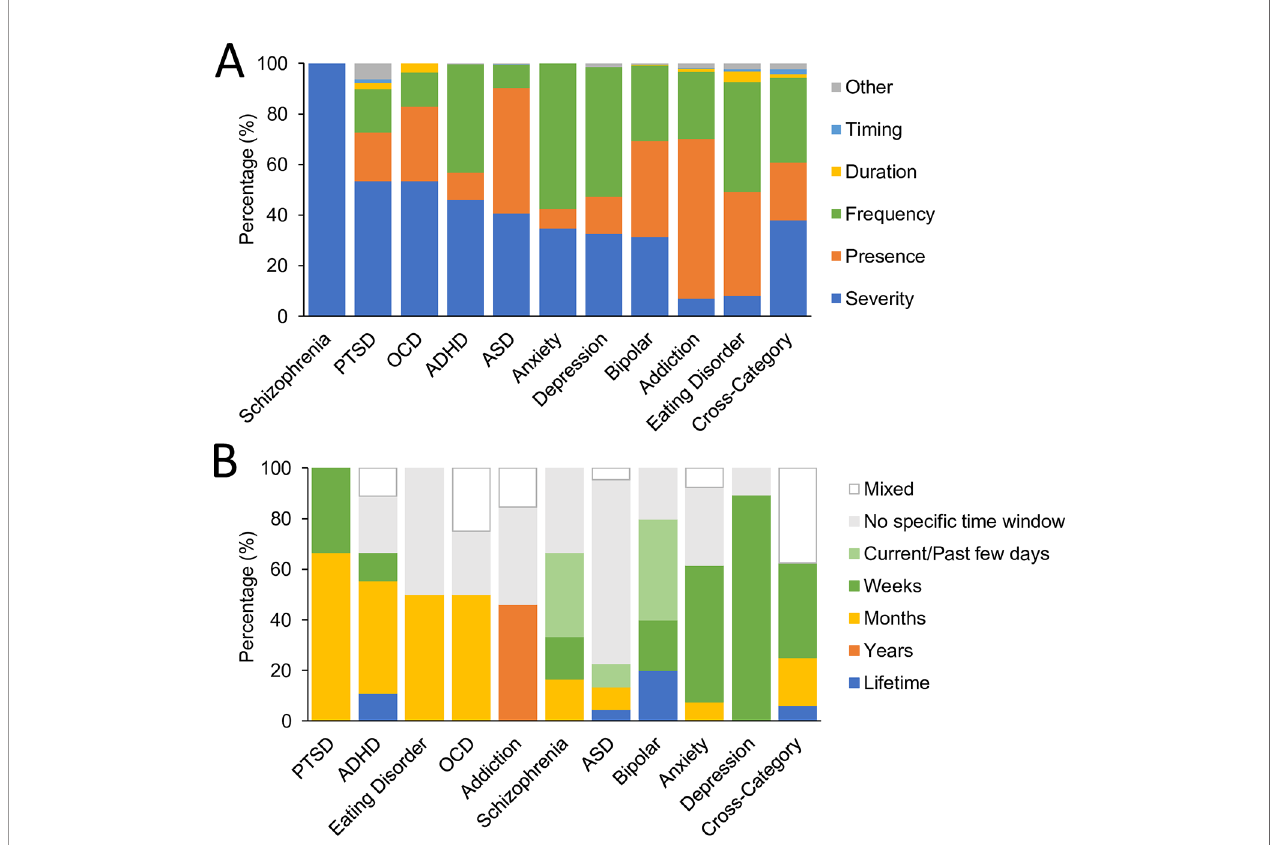
FIGURE 2 | Symptom assessment characteristics. (A) Comparative proportion of questions within each disorder and for cross-disorder tools (averaged across assessment tools) by symptom aspects; presence (orange), duration (yellow), severity (dark blue), timing (light blue), or frequency (green) of the symptom. (B) Comparative proportion of assessment tools by time period of symptom assessment; currently/past few days (includes past 24 h and past 48 h; pale green), weeks (includes past week and past 2 weeks; dark green), months (includes past month, past 3 months and past 6 months; yellow), years (includes past year and past 2 years; orange), lifetime (includes childhood, adulthood, lifetime and lifetime episodes, blue), no speci fi c time window (gray), and mixed